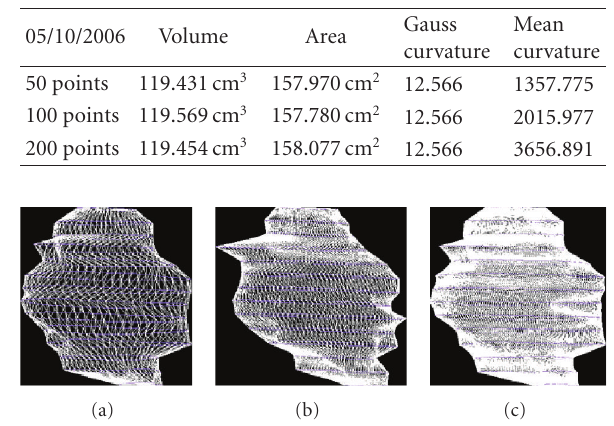
Figure 20: Patient 1. (a) 50 points on the contours, (b) 100 points on the contours, and (c) 200 points on the contours.